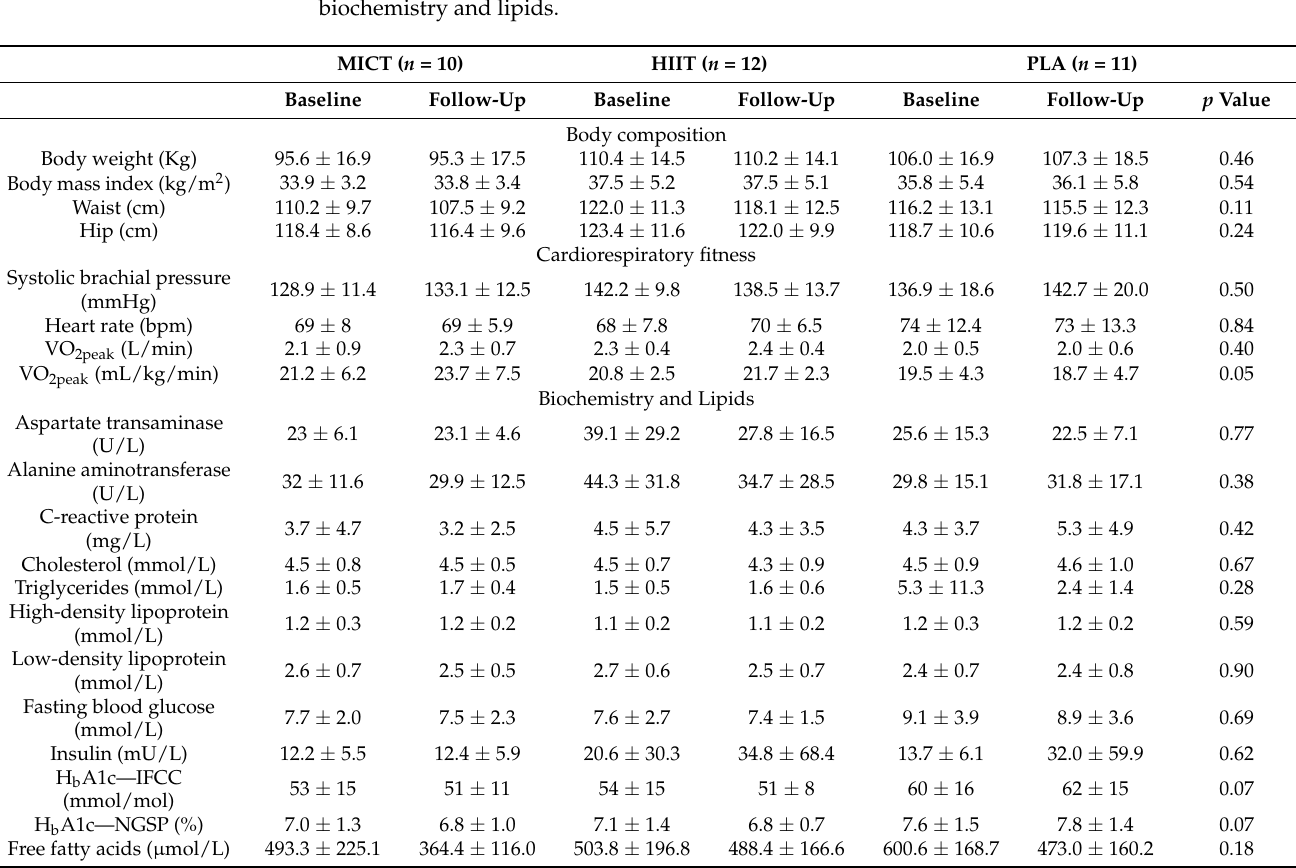
Table 3. Group mean change scores for measures of body composition, cardiorespiratory fitness, biochemistry and